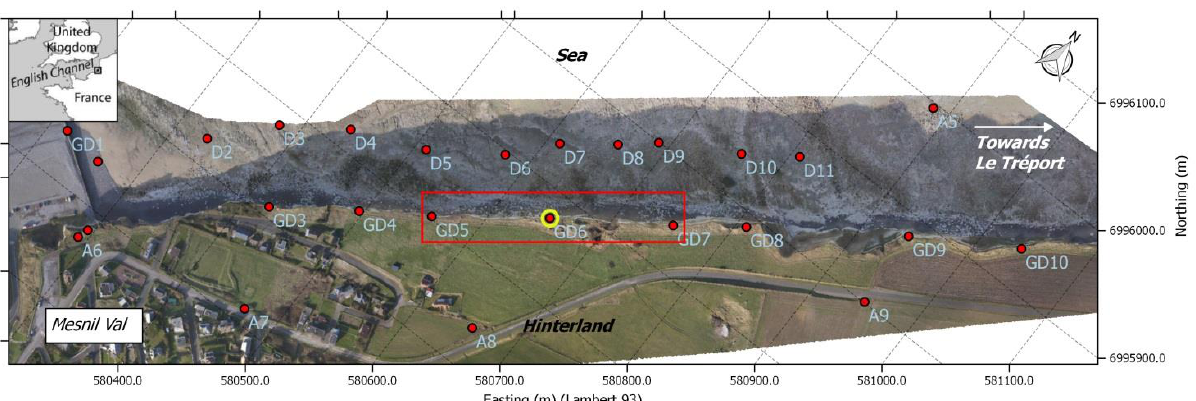
Figure 2 : Orthophotography of Mesnil Val chalk cliff site from the UAV 27 January 2015 survey. Ground Control Points (GCP) location are symbolised in red point. Target GD6 in the centre is marked by a yellow circle. It is this GCP that was removed to test the rigidity of SFM-derived point clouds. High density point clouds are extracted from the red rectangle